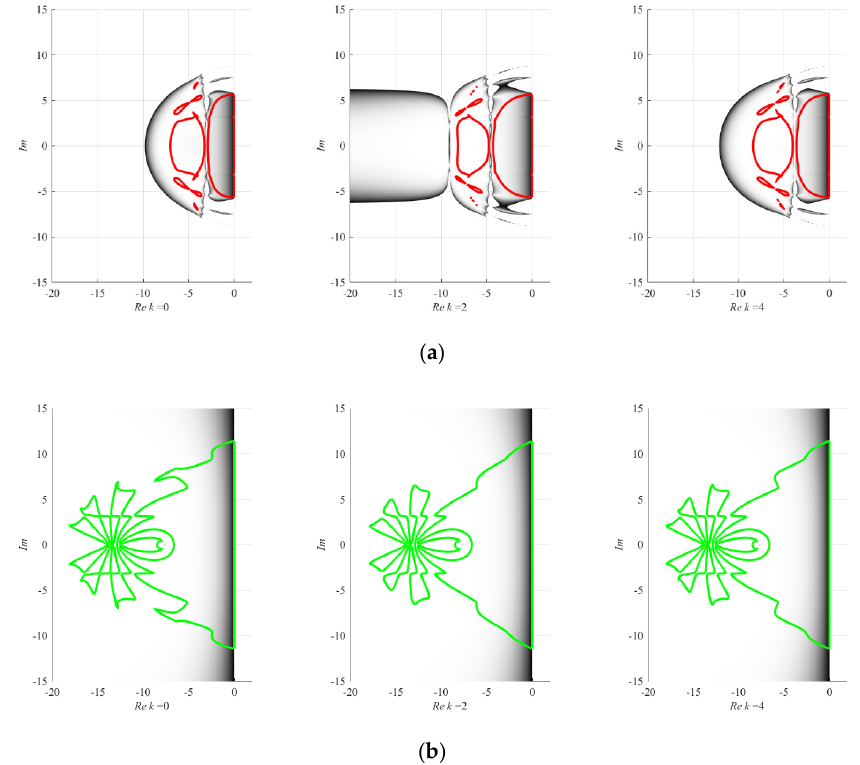
Figure 6. Stability and preference regions of XA5 composition scheme obtained for semi-implicit CD ( a ) and implicit midpoint ( b ) solvers as basic methods.